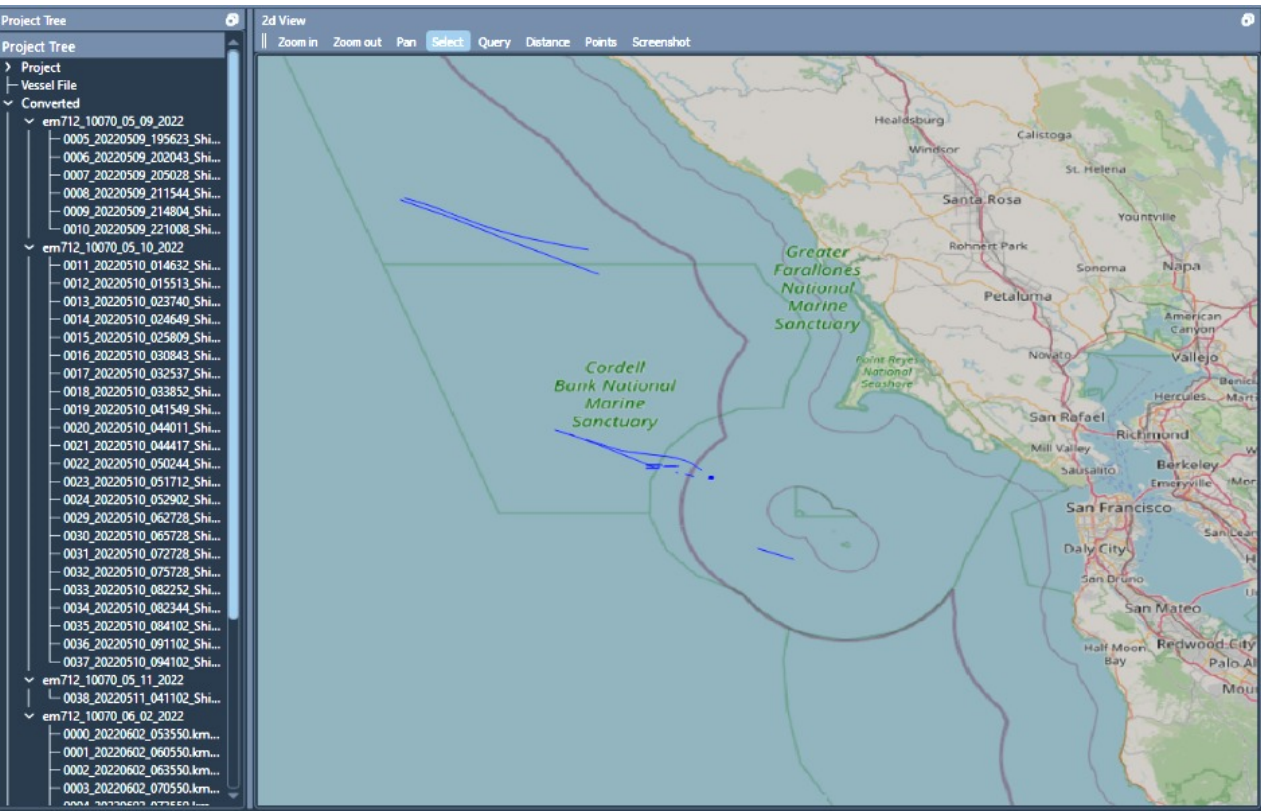
Figure 3. Map view of the project area in Kluster, multibeam tracks shown in blue.